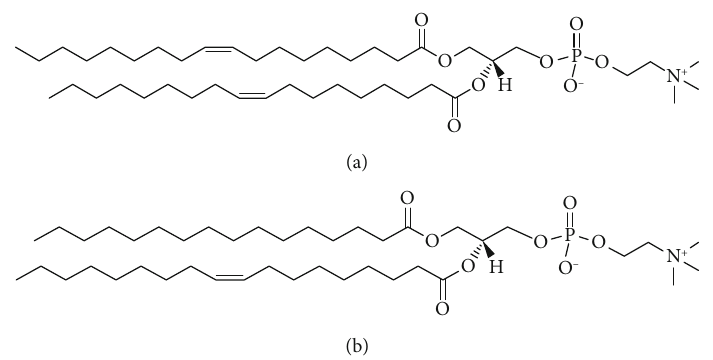
Figure 5: Chemical formula of (a) DOPC and (b) POPC.